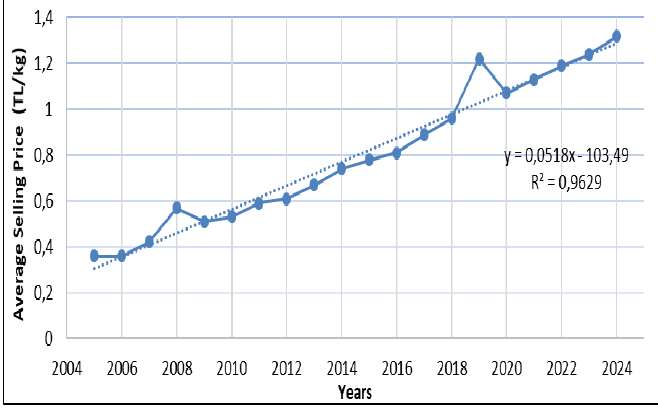
Figure 4: The average sales price of wheat in Turkey between the years 2005 to 2024.